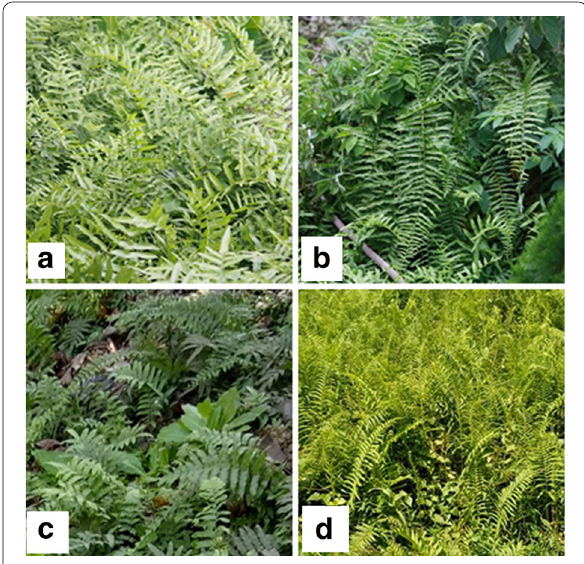
Fig. 1 Studied population of a Ampelopteris prolifera (open environment from University Campus), b A. prolifera (shade environment from University Campus), c A. prolifera (semishade population from Chakdah area near river Ganges) d Thelypteris interrupta (Open swampy environment near Magra–Talandu Railway